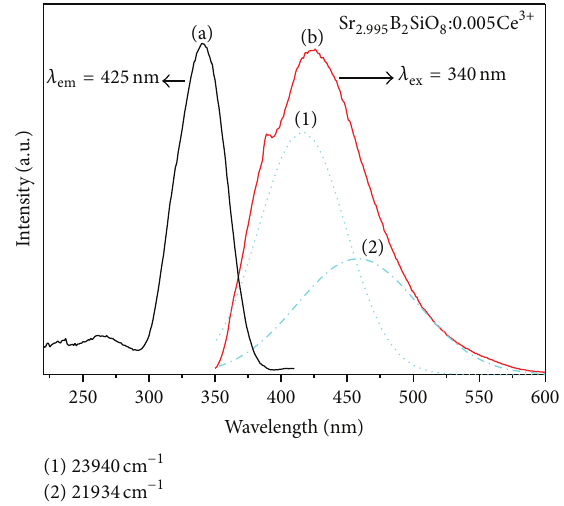
Figure 2: Photoluminescence excitation ((a) 𝜆 em = 425 nm) and emission ((b) 𝜆 ex = 340 nm) spectra of Sr 2.995 B 2 SiO 8 :0.005Ce 3+ .